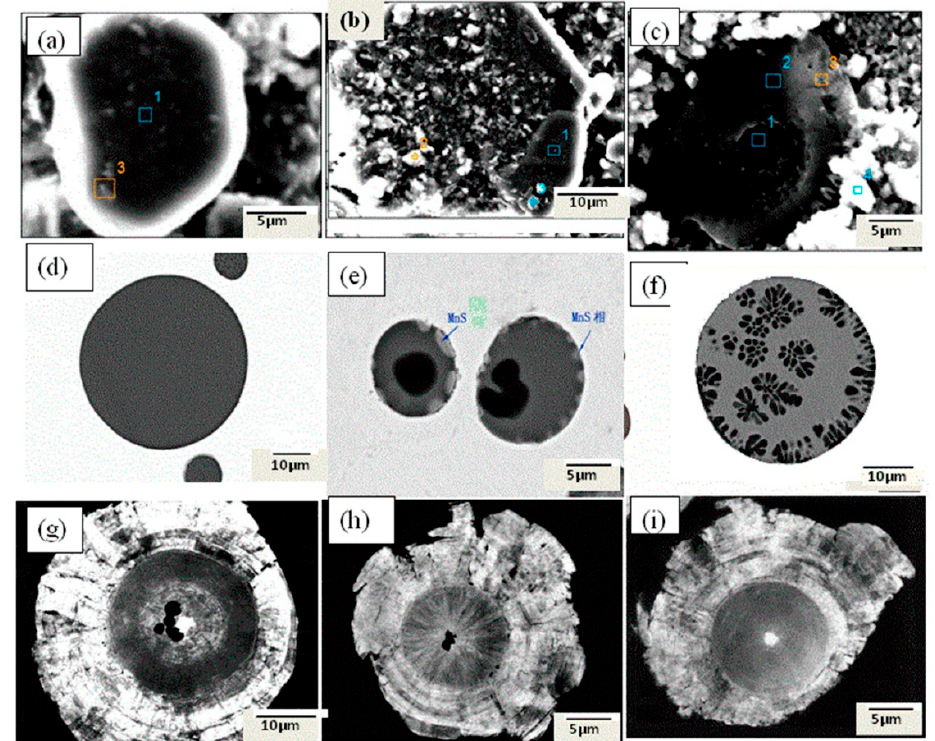
Figure 11. Exposed inner structures of extracted inclusions as cut using the RTO technique: ( a ) single Al2O3-based inclusion, ( b ) aggregated Al 2 O 3 -based cluster, ( c ) CaO-SiO 2 based inclusion, ( d ) homogeneous spheroidal SiO 2 -MnO-CaO-Al 2 O 3 inclusion, ( e ) SiO 2 -rich phases precipitating within the spheroidal SiO 2 -MnO-CaO- Al 2 O 3 inclusion and a spindle-like MnS phase on the inclusion surface, ( f ) tiny dendritic structure SiO 2 -rich phases precipitating both on the SiO 2 -MnO-CaO- Al 2 O 3 inclusion surface and as inner inclusions, ( g – i ) one or several rare-earth oxides acting as a crystal core in the spheroidal graphite [97] .